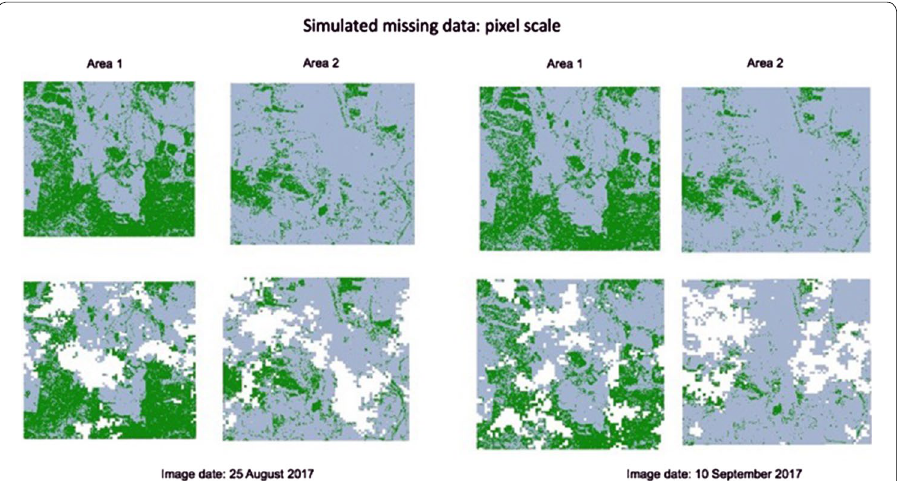
Fig. 4 Binary plots of NDVI for two smaller areas within the Landsat 8 images at pixel scale. White indicates simulated cloud, green indicates forest and grey indicates not forest land cover. The image dated 25 August 2017 is at time t + 1 and the image dated 10 September 2017 is time t +